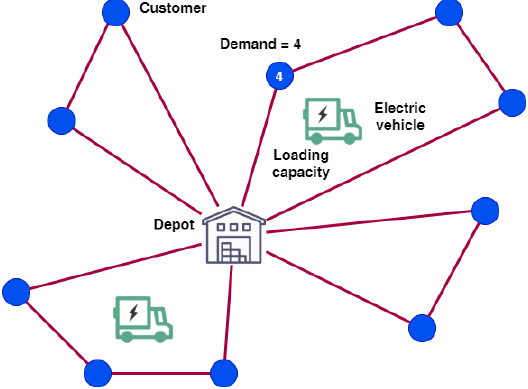
Figure 3. Visual representation of a basic